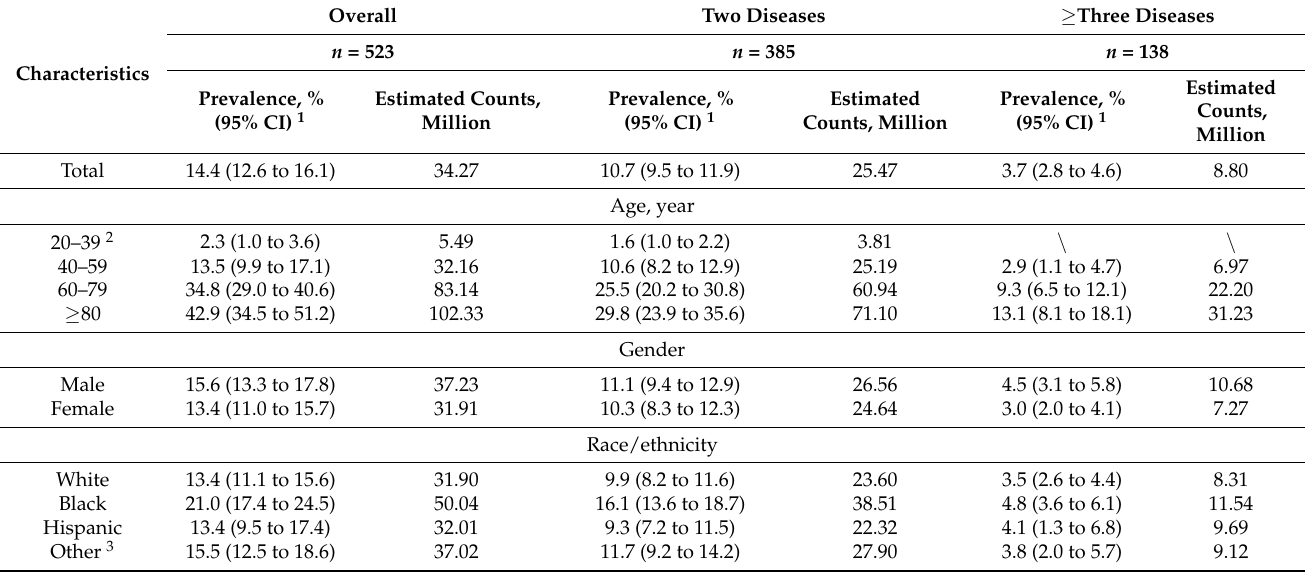
Table 1. The prevalence of cardiometabolic multimorbidity among adults in the U.S., 2017–2018.